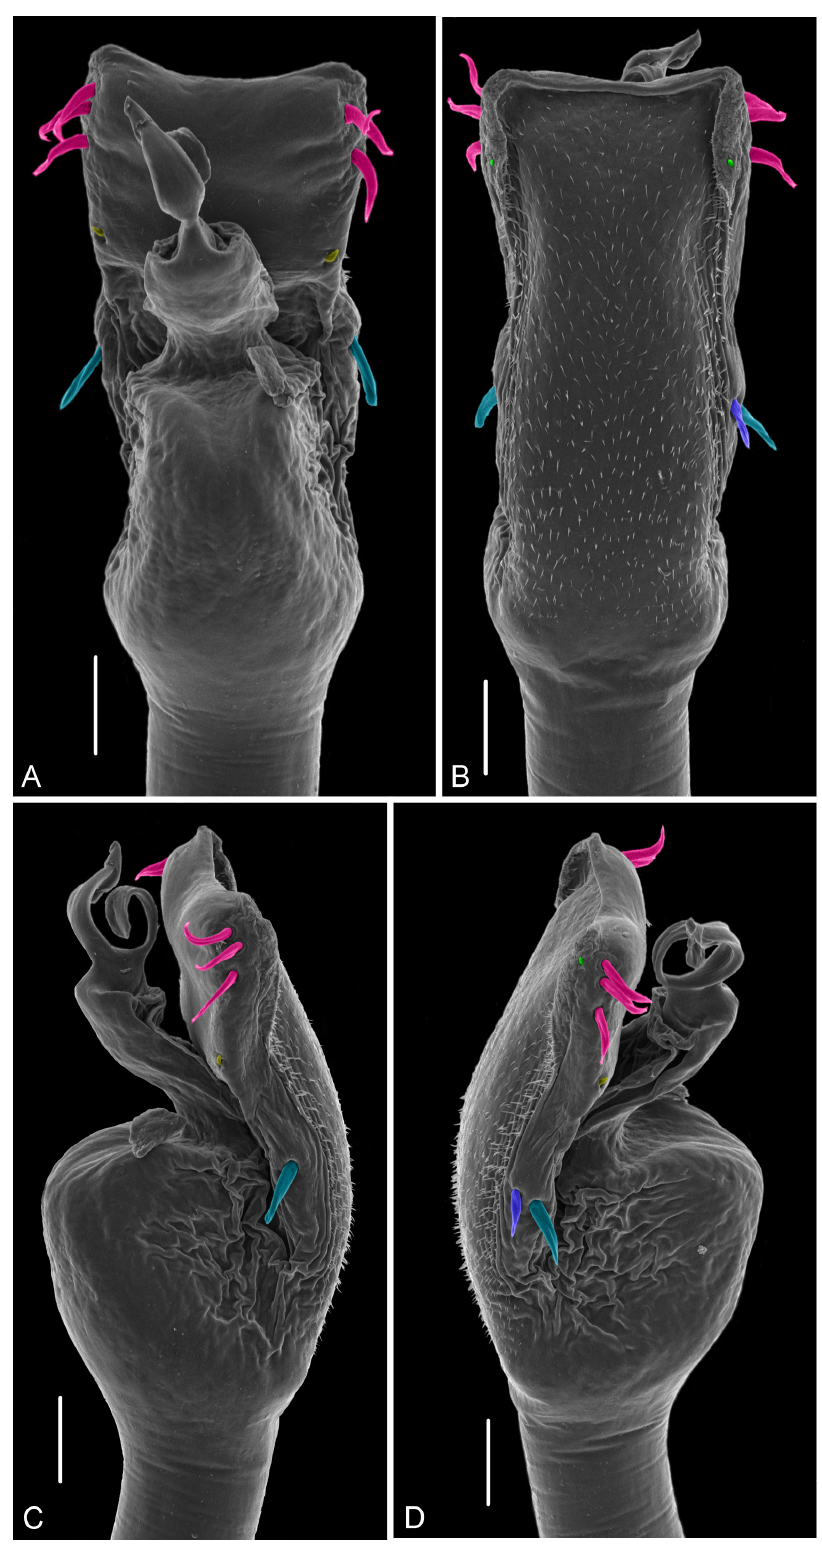
Fig. 3. Eusarcus capixaba sp. nov., ♂, holotype (ISLA 12966), distal part of penis. A . Dorsal view. B . Ventral view. C . Right lateral view. D . Left lateral view. Macrosetae highlighted in different colours: light blue = MS A; purple = MS B; pink = MS C; yellow = MS D; green = MS E. Scale bars = 50